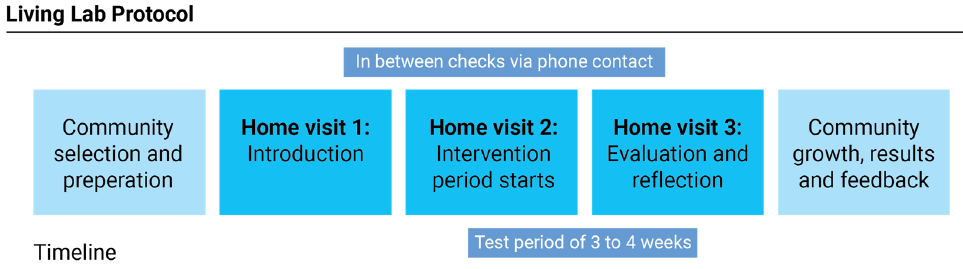
Figure 1. The Living Lab protocol used for evaluating interventions in context [17].